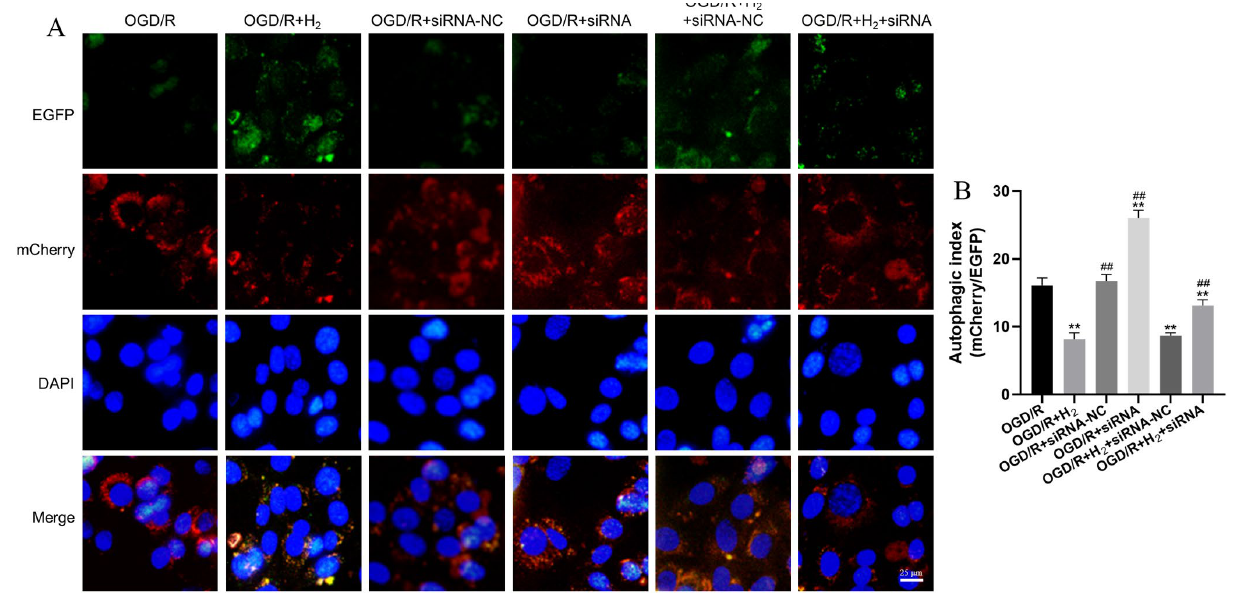
Figure 9. LincRNA- EPS knockdown abolished the effect of H 2 on autophagic flux. ( A ) HT22 cells Figure 9. LincRNA-EPS knockdown abolished the effect of H 2 on autophagic flux. ( A ) HT22 cells were transfected to stably express the mCherry − EGFP − LC3B reporter. ( B ) The ratio of mCherry + puncta to EGFP + puncta (autophagic index) was determined to quantify the autophagic flux. The mean autophagic index was plotted, with each data point corresponding to a minimum of 25 exam- ined cells (Scale bar: 25 µ m). Data were reported using a mean ± SD format. A minimum of three separate repetitions of the experiments produced similar findings. ** p < 0.01 vs. OGD/R group. ## p < 0.01 vs. OGD/R+ H 2 group.